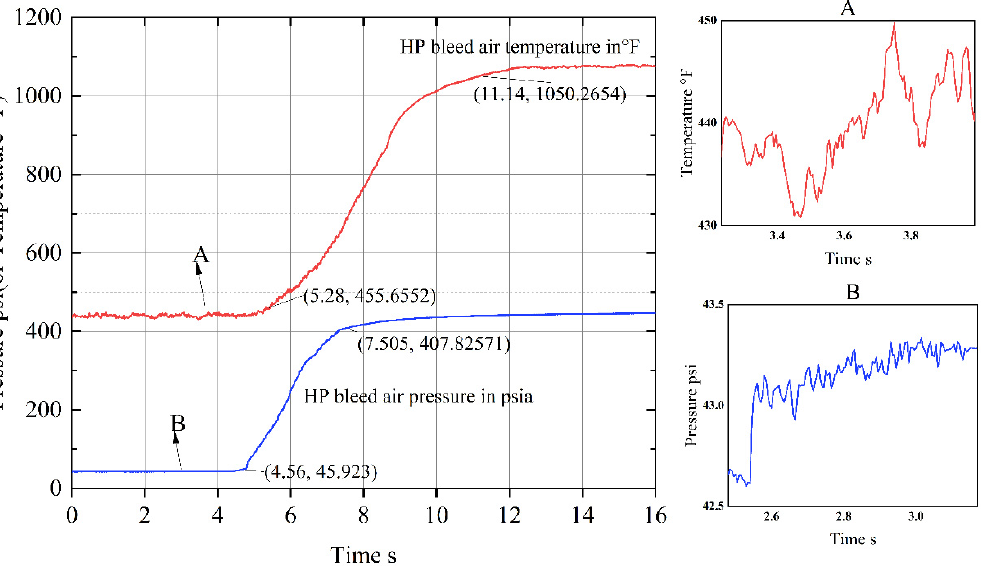
Figure 11. The HP bleed air temperature and pressure rapid rise characteristics of the cooling ‐ pack ‐ age ‐ two on HPR. package-two on